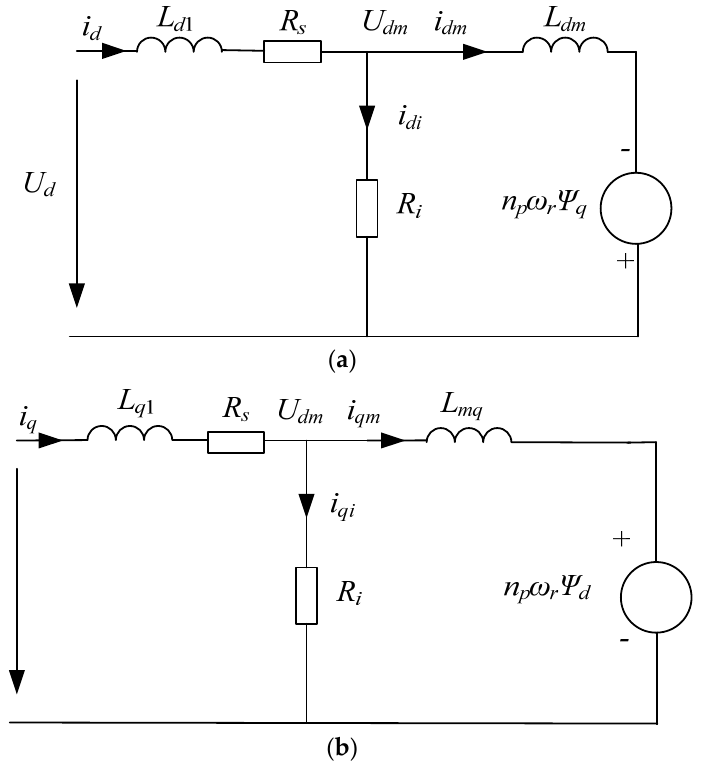
Figure 1. Decoupled mathematics model of PMSM: ( a ) Dynamic mathematical model in d ‐ axis; ( b ) Dynamic mathematical model in q ‐ axis.